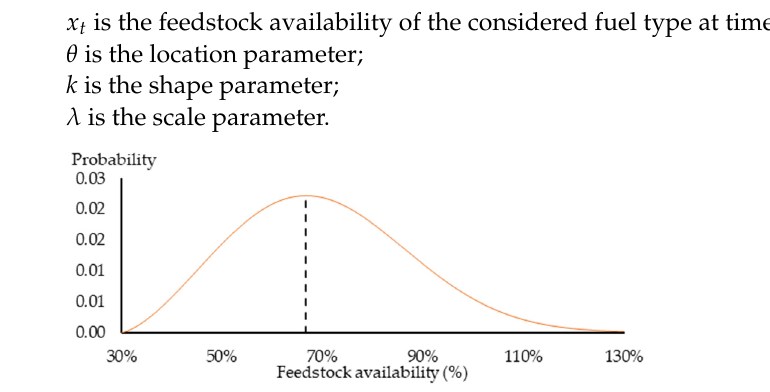
Feedstock Availability